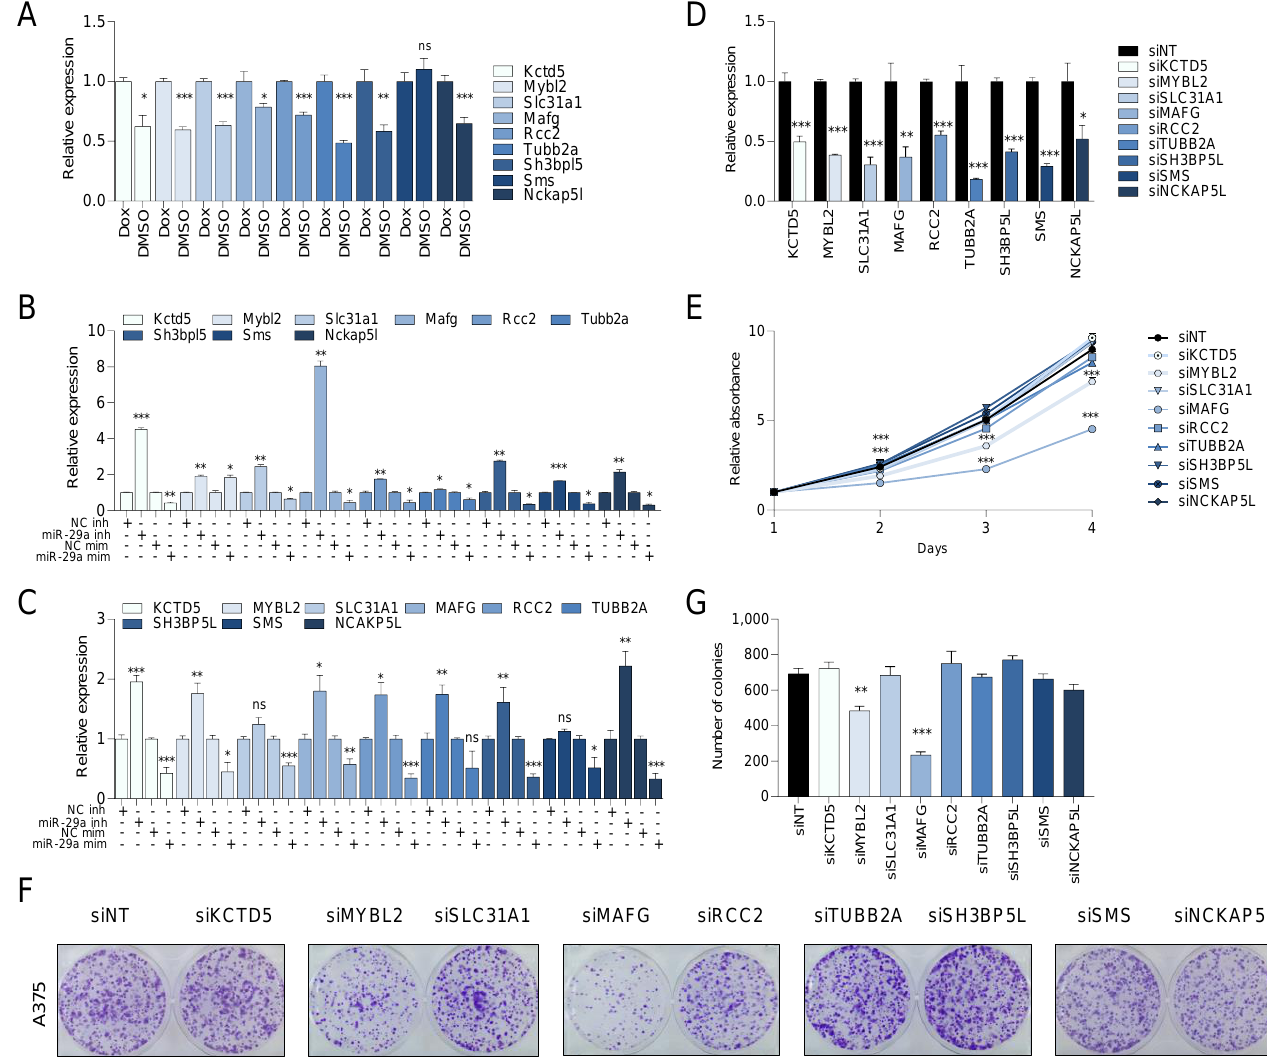
Figure 4. miR-29 targets constitute a vulnerability of melanoma. ( A ) expression of the nine putative miR-29 target genes upon miR-29 reactivation in miR-29 sponge melanoma cells; ( B , C ) expression of the nine putative miR-29 target genes upon miR-29 inhibitor or mimic transfection in miR-29 sponge melanoma cells ( B ) or human A375 melanoma cells ( C ). The mean ± SEM of one representative out of three independent experiments performed in triplicates is shown. Gene expression levels are normalized to β-Actin (mouse) or GAPDH (human); ( D ) validation of the efficacy of the ON-TARGETplus siRNA pool for the nine identified putative miR-29 targets; ( E ) effect of silencing the nine putative miR-29 targets on proliferation of A375 cells; ( F ) effect of silencing the nine putative miR-29 targets on focus formation of A375 cells; ( G ) quantification of colony formation shown in ( F ). The mean ± SEM of one representative out of two independent experiments performed in quadruplicates is shown. ns, not significant; * p < 0.05; ** p < 0.01; *** p < 0.001.